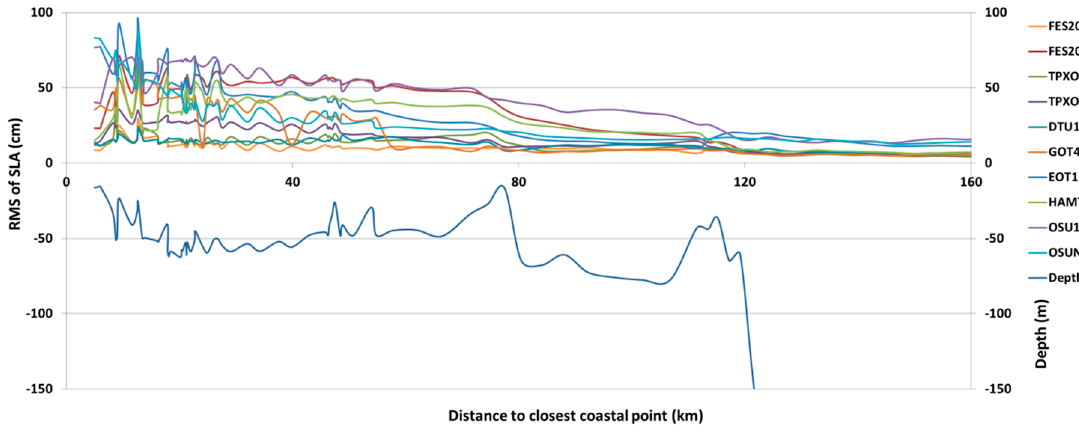
Figure 6. SLA RMS values of the Sentinel-3A mission (pass 731), corrected for different tide models and plotted against distance to the coast and ocean depth.